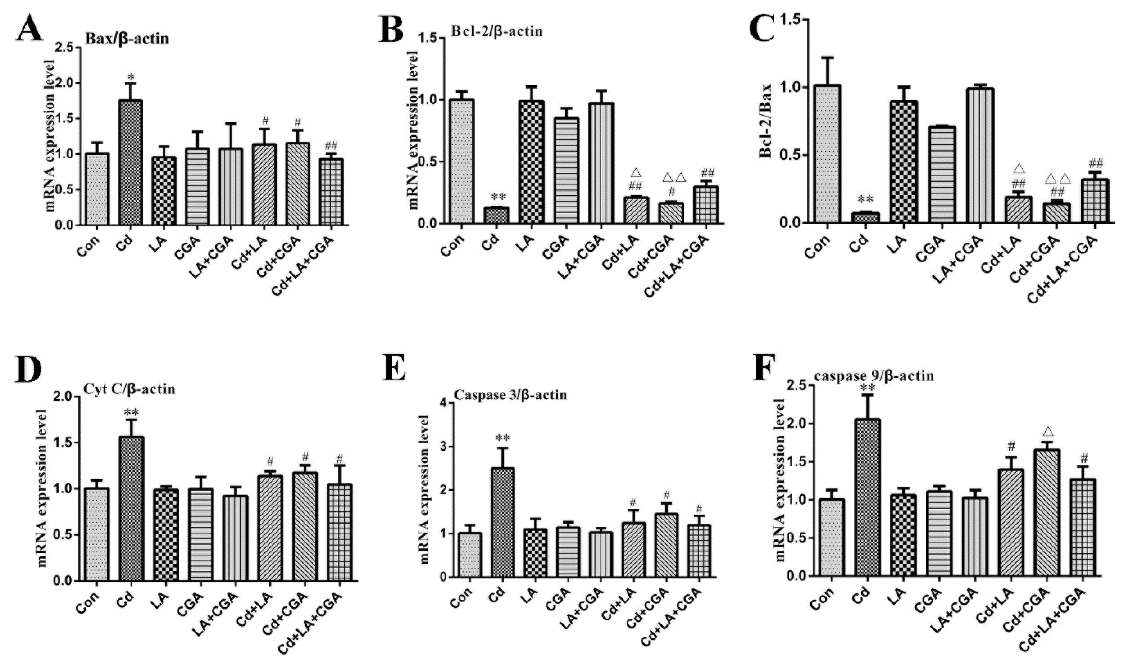
Figure 8. Effects of α -lipoic acid and chlorogenic acid on mitochondrial apoptosis gene in cadmium poisoned chicken liver. The mRNA levels of ( A ) Bax; ( B ) Bcl-2; ( C ) ratio of Bcl-2/Bax; ( D ) Cyt C; ( E ) Caspase 3; ( F ) Caspase 9 were measured by q-RT PCR. * p < 0.05, ** p < 0.01 vs. control, # p < 0.05, ## p < 0.01 compared to the Cd-treatment group, ∆ p < 0.05 and ∆∆ p < 0.01 compared to the α -LA + CGA + Cd